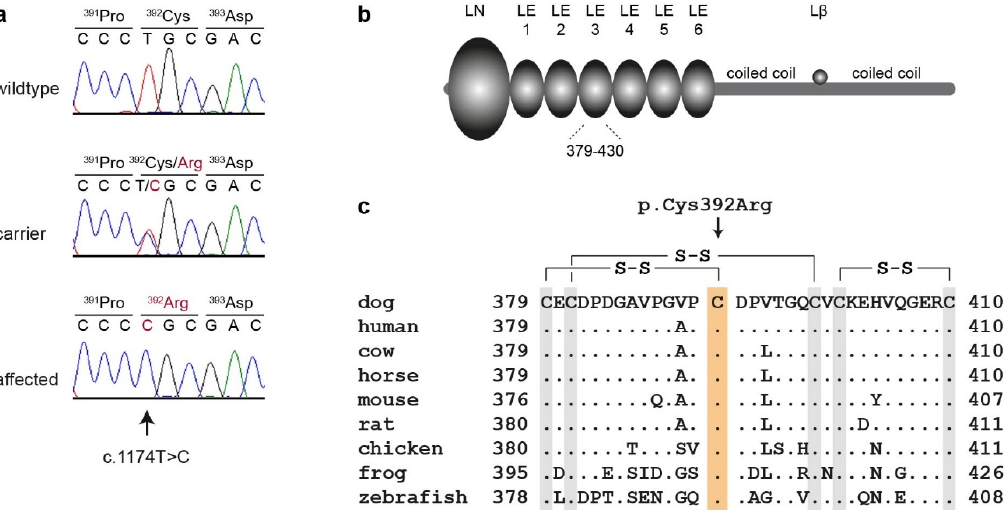
Figure 3. Details of the LAMB3 :c.1174T>C, p.Cys392Arg variant. ( a ) Representative electropherograms of three dogs with different genotypes are shown. The variable position is indicated by an arrow, and the amino acid translations are shown. ( b ) Domain organization of the 1172 amino acid laminin β3 precursor [8]. The N-terminus consists of a globular domain (LN), followed by six laminin EGF-like (LE) domains. These N-terminal domains are located in the basement membrane and may be involved in binding to collagen VII. The C-terminal half of laminin β3 participates in two coiled-coil domains that mediate trimerization with the α3 and γ2 chains in the laminin-332 heterotrimer. The small L β